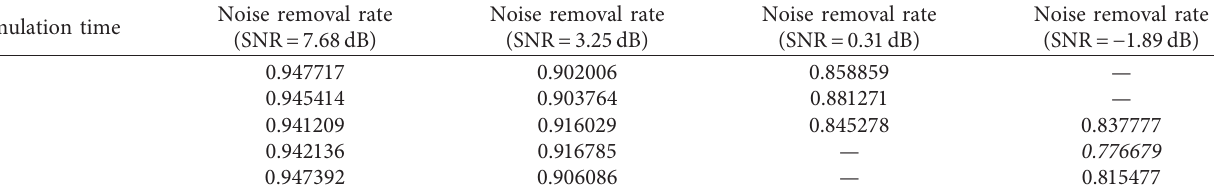
Table 3: Noise reduction result.